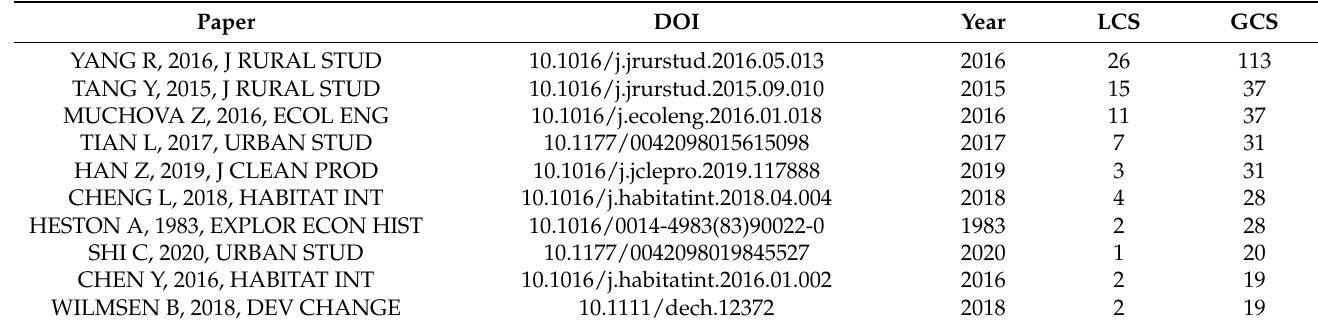
Table 6. The Top 10 Literature of GCS in Land Consolidation and Rural